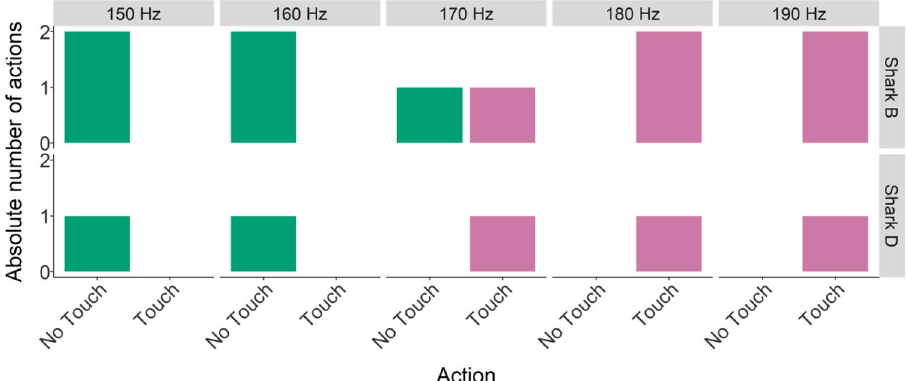
Figure 5. Grouped supersession data absolute number of action (not touching or touching the loudspeaker) per unfamiliar frequency (150–190 Hz).